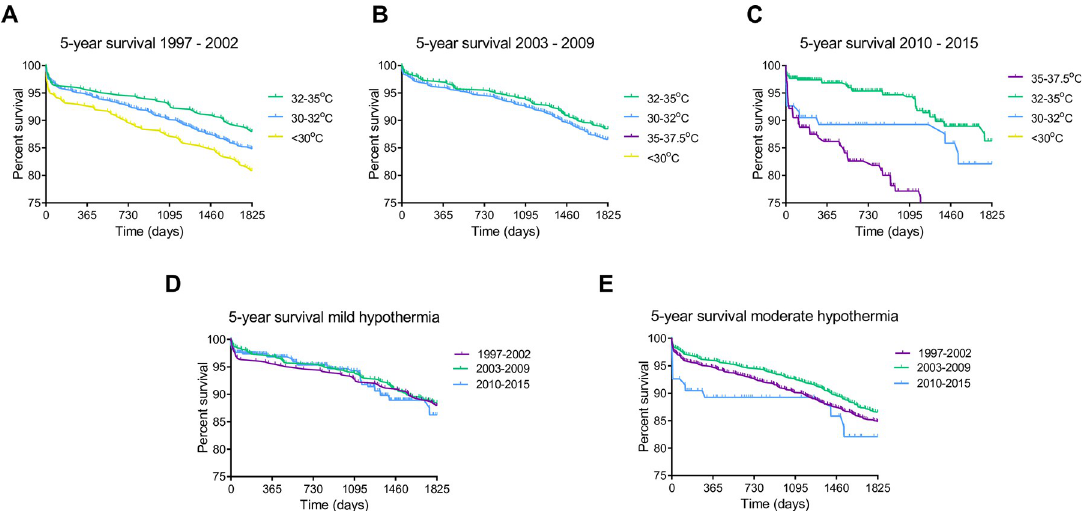
Fig 2. 5 year survival per categorized minimal nasopharyngeal temperature per time period, including (a) 1997–2002, (b) 2003–2009 and (c) 2010–2015. https://doi.org/10.1371/journal.pone.0273370.g002 Whereas patients with mild and moderate hypothermia showed high 30-day survival (both 98%), the more extreme groups of severe hypothermia and normothermia showed signifi- cantly lower survival, amounting 93% (Fig 3A; Log rank χ 2 = 54, p < 0.001). Notably, after